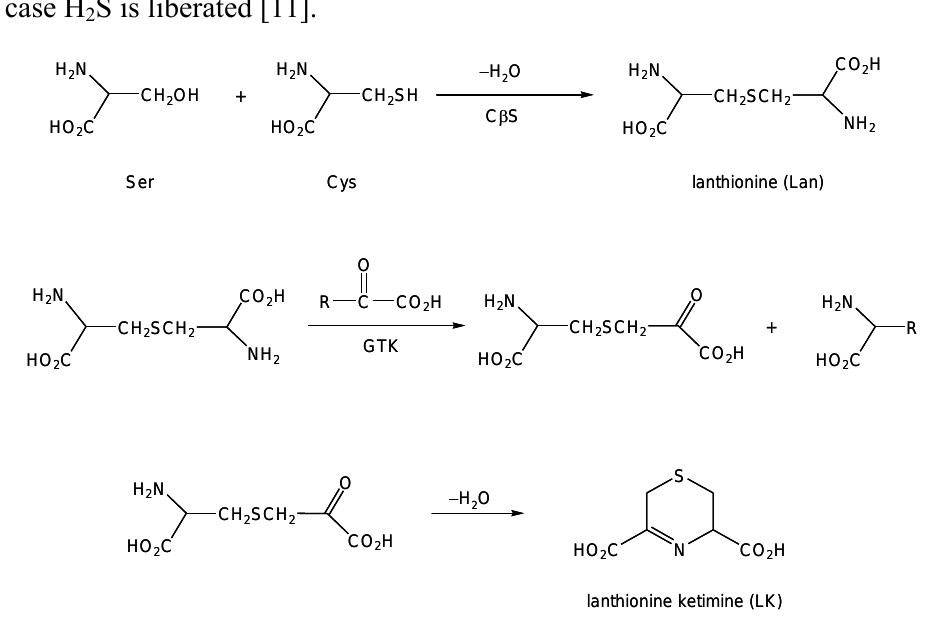
Figure 1. A: Structure and numbering convention for lanthionine ketimine (LK) tautomers and synthetic derivatives. For natural lanthionine ketimine, R between the imine and ene-amine forms of LK.